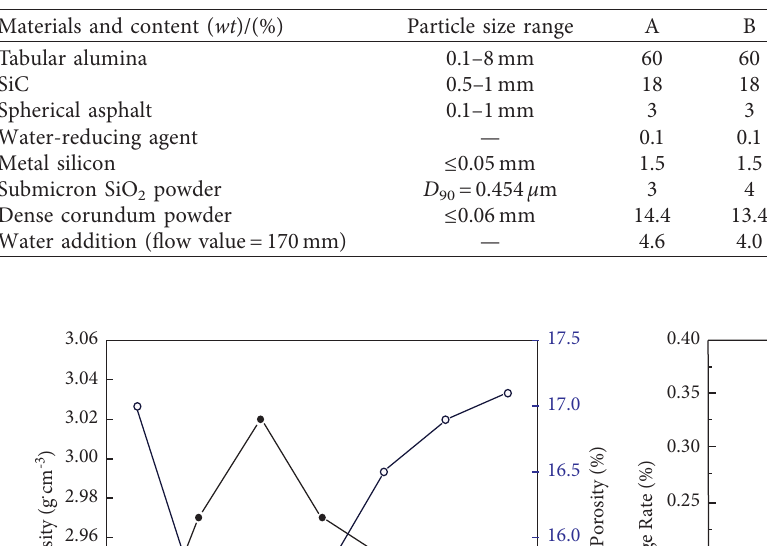
Table 2: Formulations for the experiment.